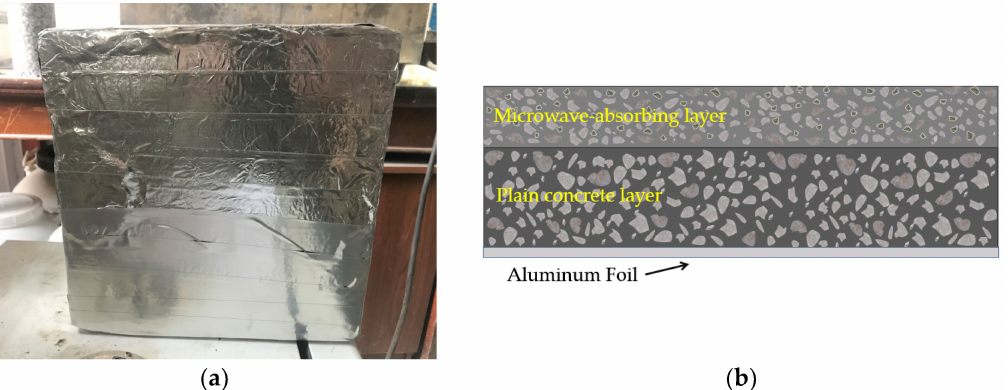
Figure 8. Microwave-absorbing cement concrete with shielding at the bottom surface: ( a ) Bottom surface shielded concrete specimen. ( b ) Schematic diagram of the bottom shielded concrete specimen.